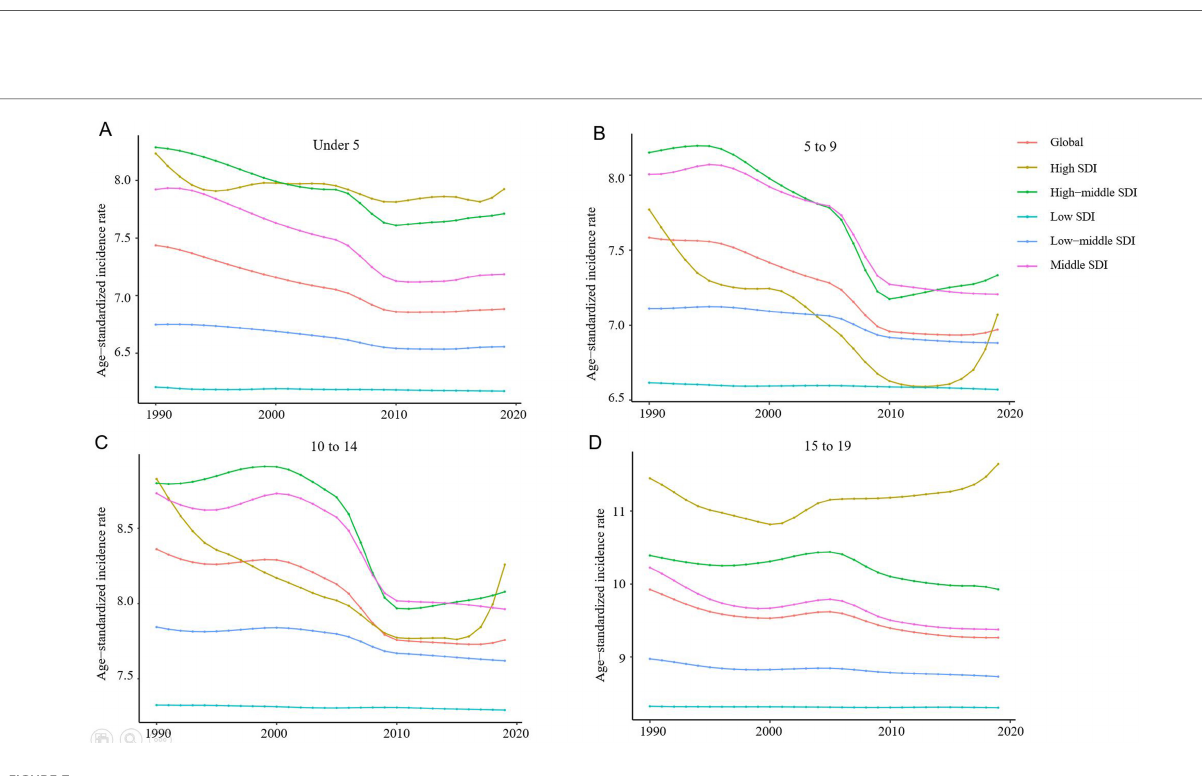
FIGURE 7 Change in trends of age-standardized incidence rate due to childhood myocarditis and cardiomyopathy by age group and SDI from 1990 to 2019. ( A ) Change in trend of age-standardized incidence rate for under 5-year-olds. ( B ) Change trends of age-standardized incidence rate for 5 to 9-year- olds. ( C ) Trends in age-standardized incidence rates in children aged 10 to 14 are similar to those of children aged 5 – 9. ( D ) Change in trend of age- standardized incidence rate for 15 – 19-year-olds. SDI, sociodemographic